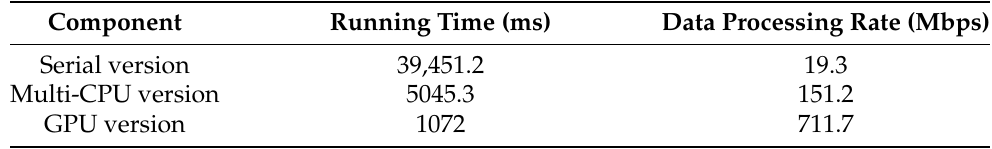
Table 5. The comparison between GPU version and serial